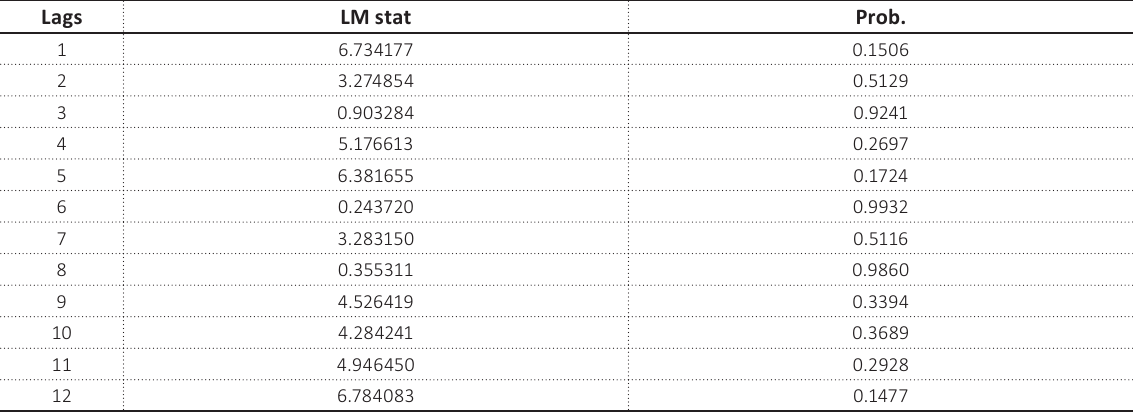
Table 7. VAR residual serial correlation LM